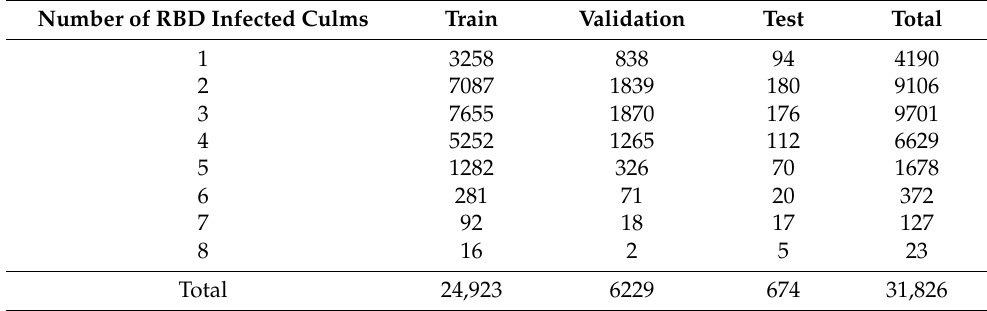
Figure 14. Example of data by number of culms of RBD (The numbers in the upper left mean the actual number of culm). Table 4. The data for classification of RBD infected